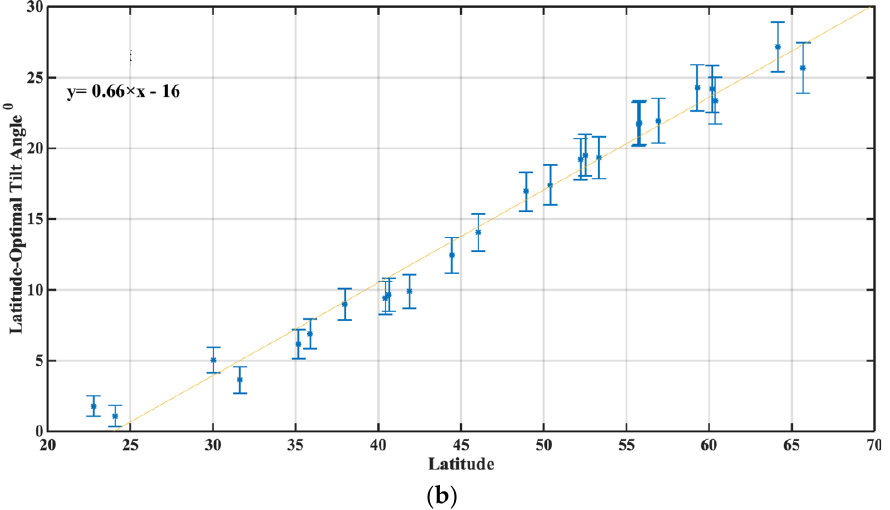
Figure 5. Optimum tilt angle with 1 σ against latitude for all cities and corresponding linear regres- sion ( a ). Difference of Latitude and Optimum tilt angle with 1 σ against latitude for all cities and corresponding linear regression ( b ).